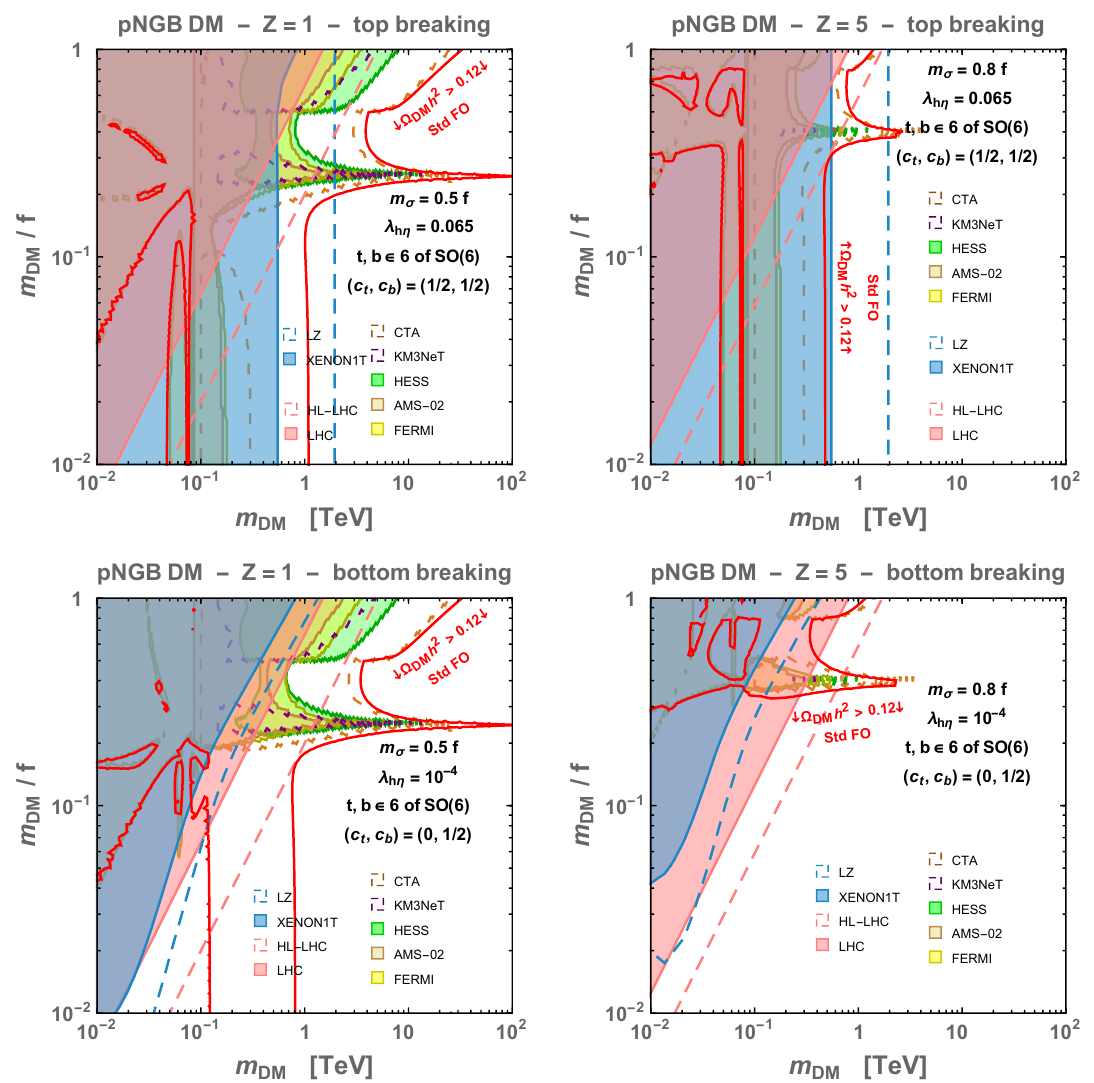
Figure 14 . Dilaton-mediated O(6)/O(5) pNGB DM in the standard freeze-out case . Lines and shadings as in figure 3. All the rest as in figure 4, where here we additionally display the